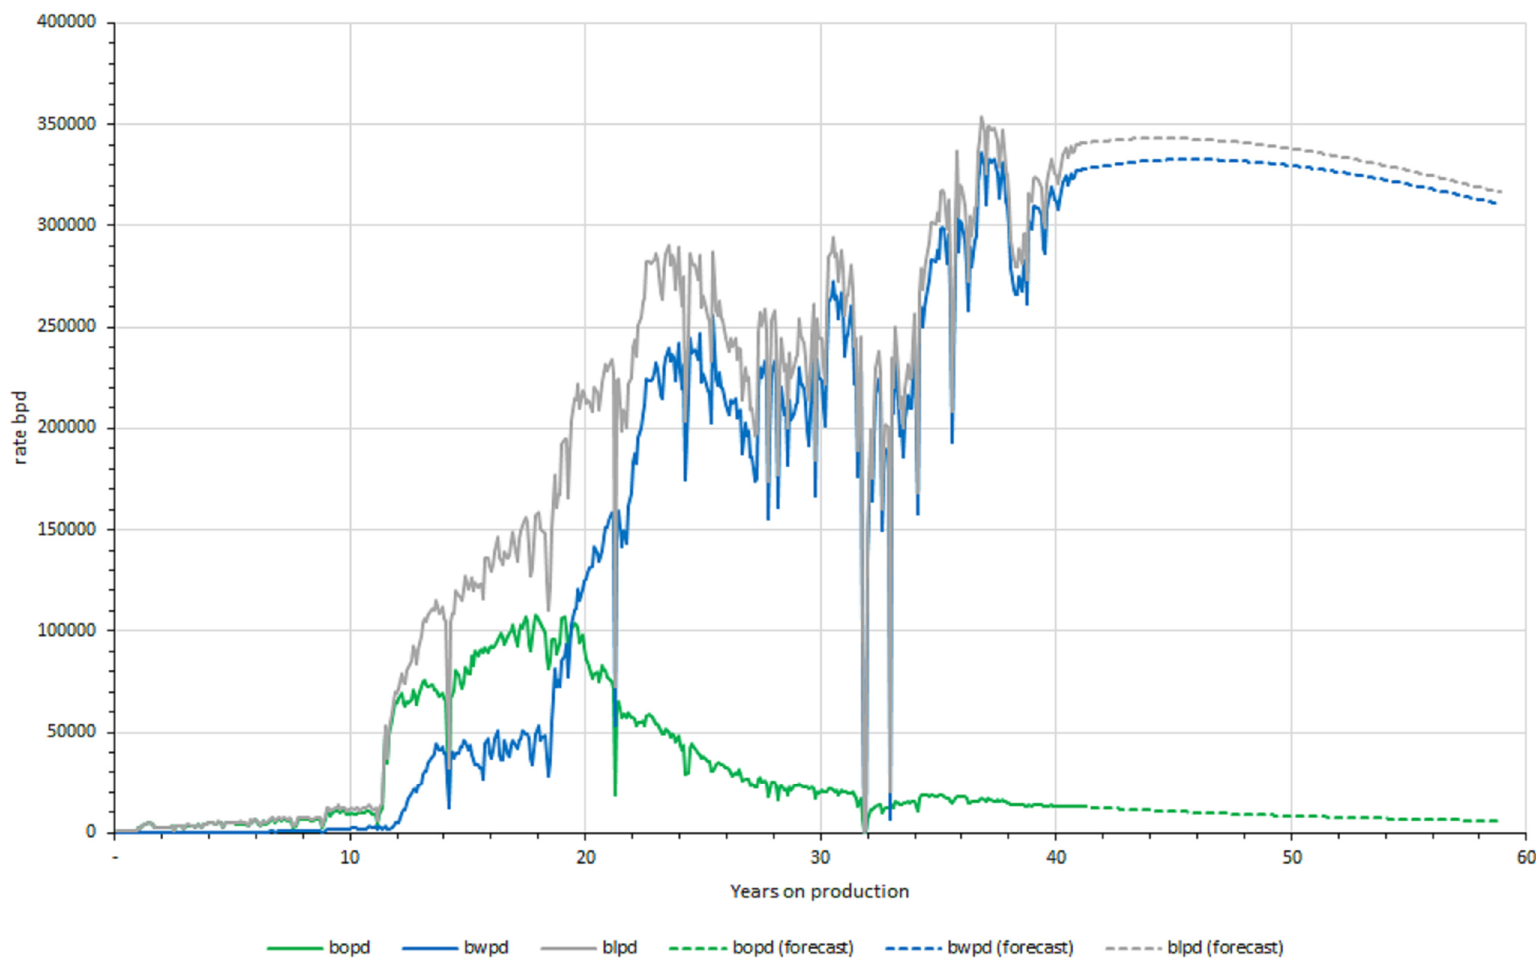
Figure 7. Decline Curve Analysis of the Wytch Farm field until 2037, time being measured from zero on 1 March 1979. Blpd = barrels of geofluid per day; bopd = barrels of oil per day; bwpd = barrels of water per day.